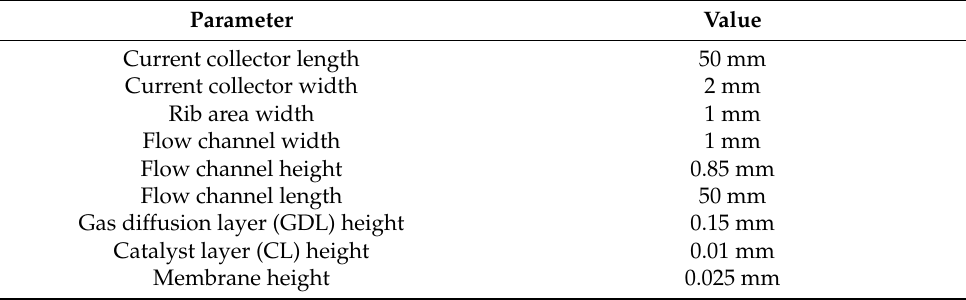
Figure 1. The schematic illustration. Table 1. Geometric parameters of the computational model. Table 1. Geometric parameters of the computational